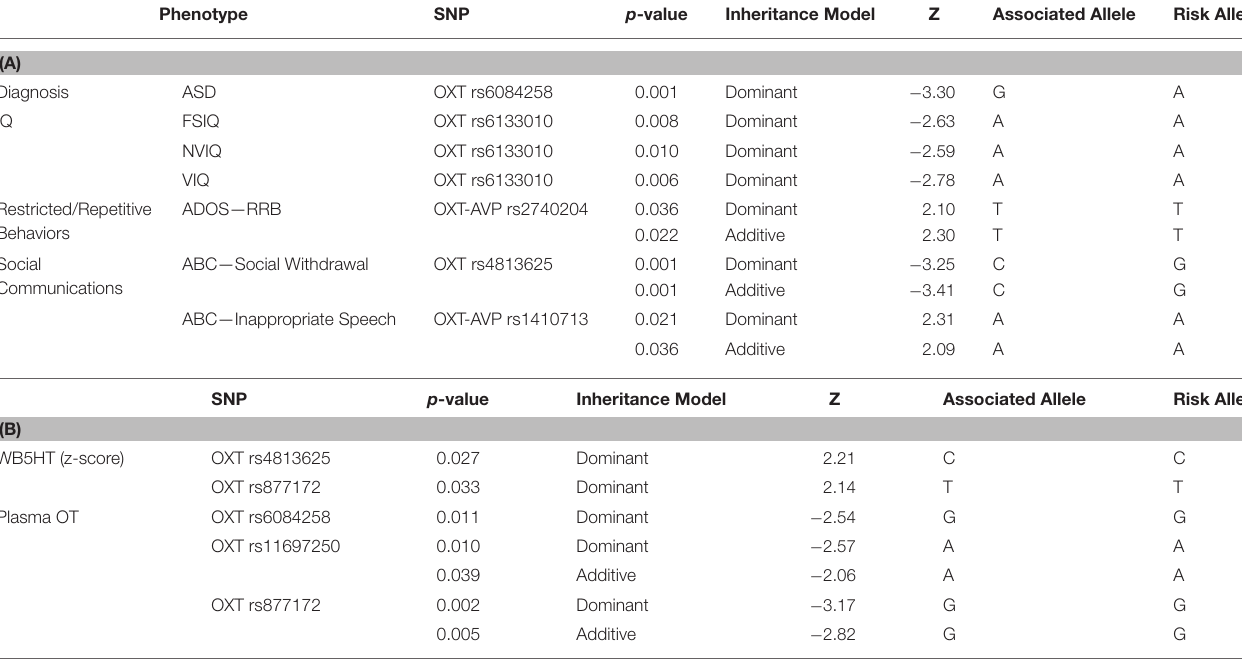
TABLE 2 | Significant associations.